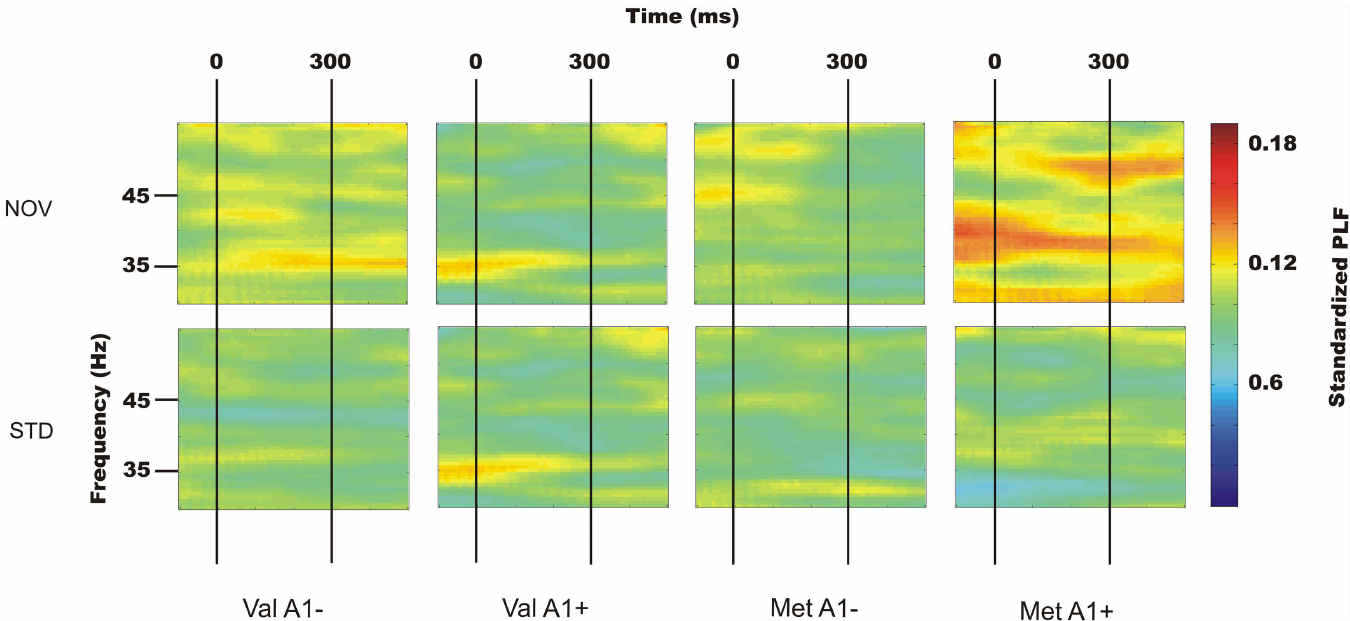
Fig 2. Standardized PLF values for novel and standard trials. Plots of standardizedPLF values for novel and standard trials are shownfor all four groups’ Cz for frequenciesfrom 30 to 55 Hz. ValA1- and MetA1+ groups showed enhancedPLF in novel comparedto standard trials around100 ms post-sound onset, whereasValA1+ and MetA1- groupshad similar PLF values to both stimulus